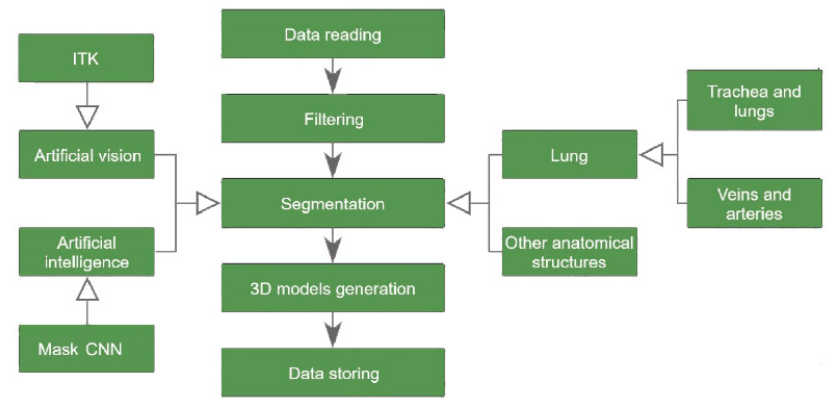
Figure 5. Diagram of the process for automatically generating 3D models.